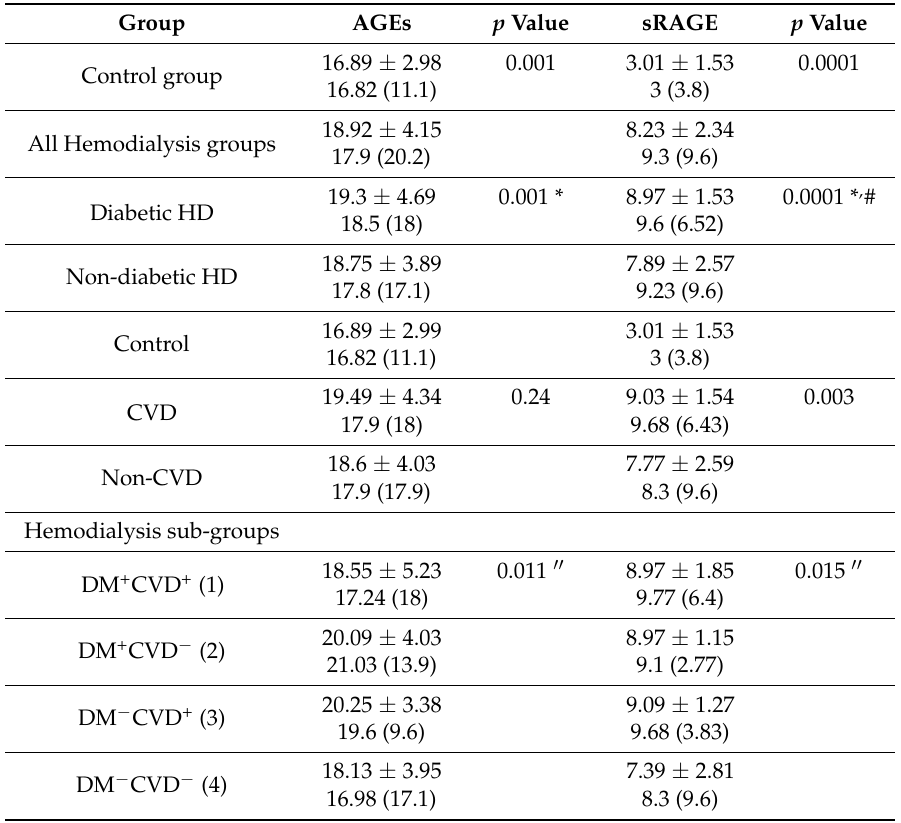
Table 3. Comparison of biochemical data among the studied groups.